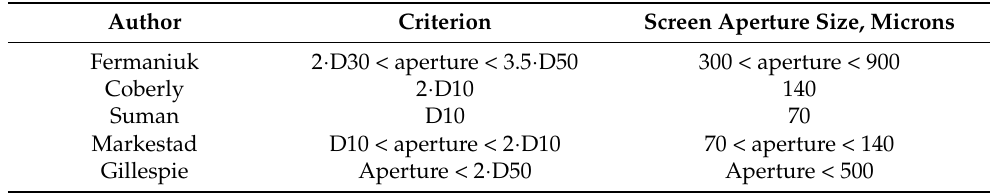
Table 1. WWS aperture sizes by different authors.